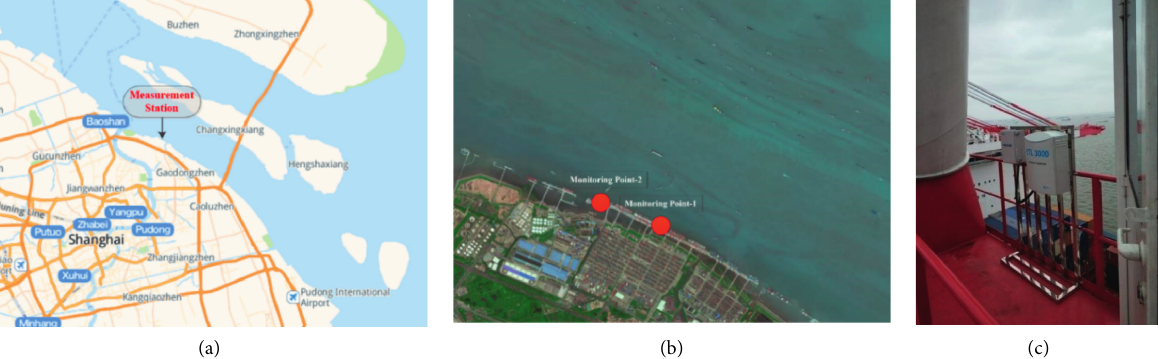
Figure 1: (a) Location of the measurement station. (b) Satellite view of the monitoring environment, with the location of the two survey stations shown in red (map source: lbs.amap.com). (c) Equipment installed at a suspension bridge on the